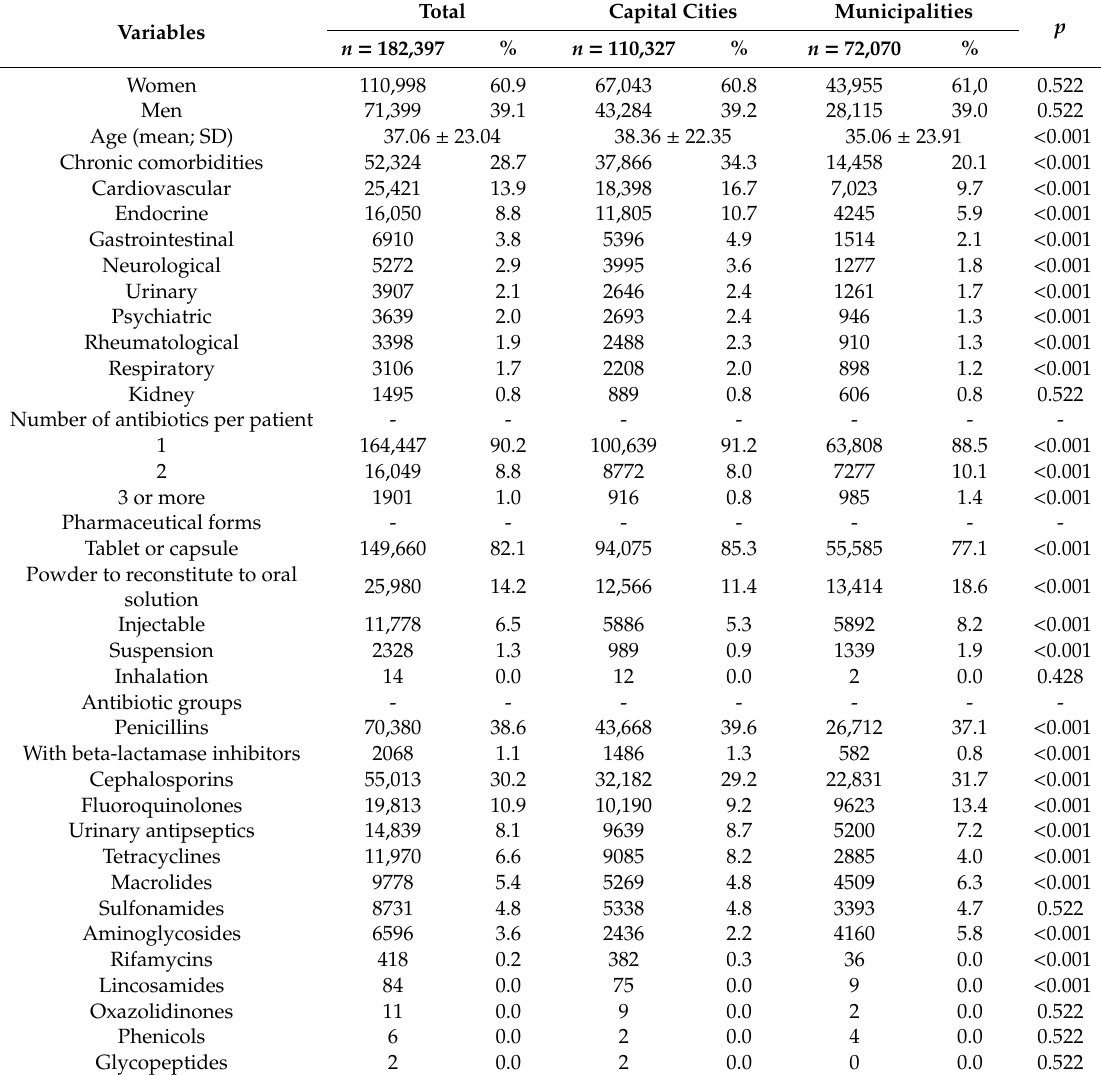
Table 1. Comparison of sociodemographic, clinical and pharmacological characteristics of the patients included in the sample according to the place their live, Capital cities or small Municipalities ( p values calculated by Chi-square / Fisher’s exact test, and adjusted using the Benjamini–Hochberg